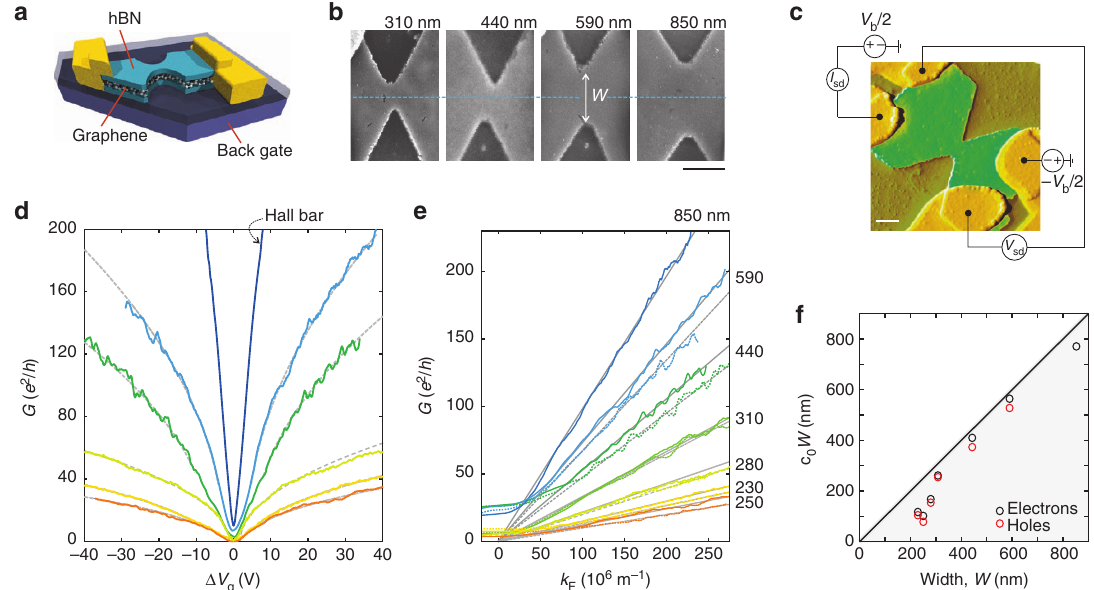
Figure 1 | Width-dependent ballistic transport in etched graphene nanoconstrictions encapsulated in hBN. ( a ) Schematic illustration of a hBN–graphene sandwich device with the bottom and top layers of hBN appearing in green, the gold contacts in yellow, the SiO 2 in dark blue and the Si back gate in purple. ( b ) SEM images of four investigated graphene constrictions patterned using reactive ion etching. Black scale bar, 500nm. ( c ) False coloured atomic force microscope (AFM) image of a fabricated device. Transport is measured in a four-probe configuration to eliminate any unwanted resistance of the one-dimensional contacts 8 . The yellow colour denotes the gold contacts, green the top layer of hBN and brown the SiO 2 substrate. White scale bar, 500nm. ( d ) Low-bias back-gate characteristics of a Hall bar device (see arrow) and of five constriction devices with different widths ranging from 850 to 230nm (see e for colour code). The dashed grey lines are fits to the data. ( e ) Low-bias four-terminal conductance of graphene quantum point contacts as function of k F extracted in the high carrier density limit for seven different samples. The colour encodes the different samples with different constriction widths (see labels). Grey lines represent a linear fit at high values of k F , inserted as guide to the eye. Conductance deviates from the expected linear slope for small k F . Electron (hole) conductance is plotted as solid (dashed) line. Data are taken at temperatures below 2K. ( f ) Comparison of c 0 W from conductance traces ( e ) with the width W (extracted from SEM